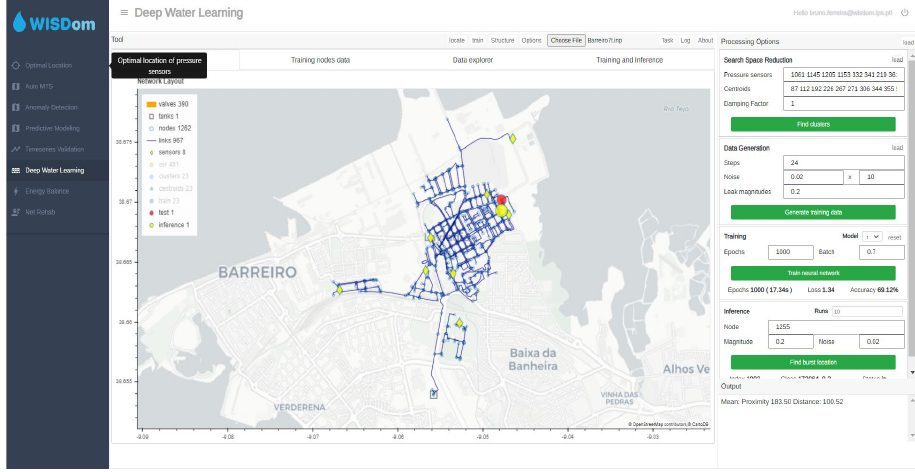
Figure 5. Screenshot of tool for the identification of the critical areas for pipe burst location.